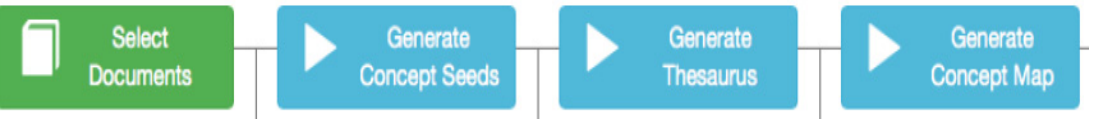
Figure 2. Project stages of the Leximancer software.